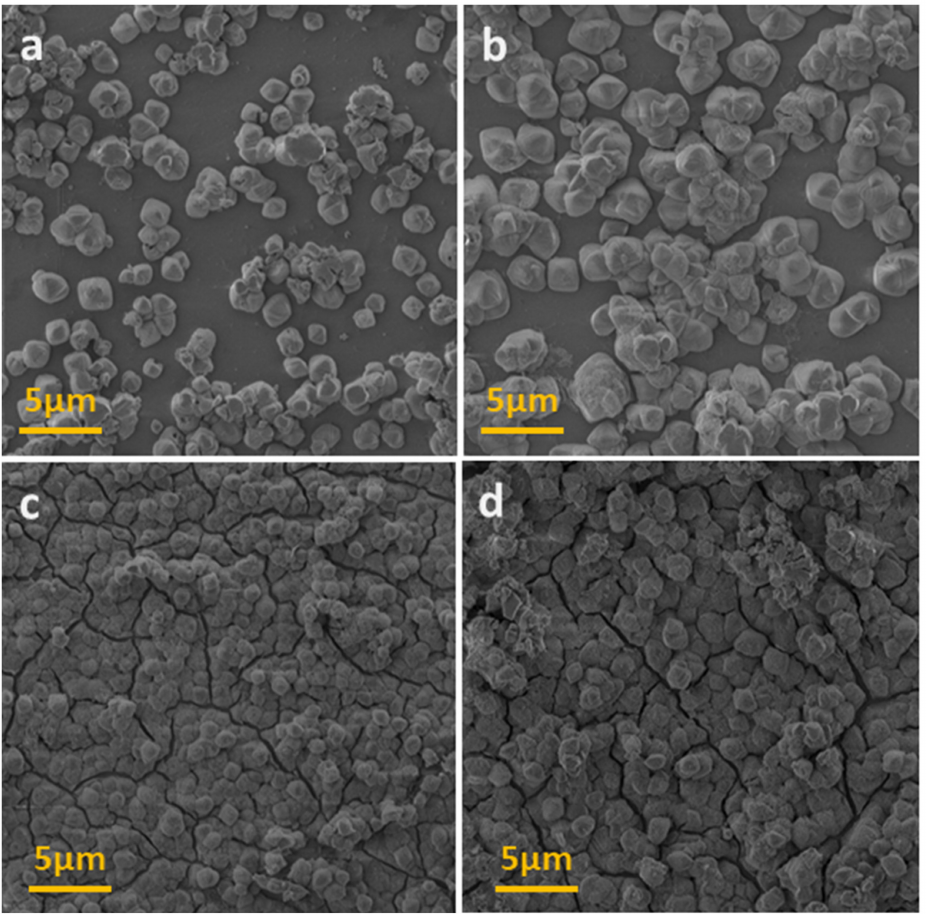
Figure 5. The SEM images of [Fe II (H 2 O) 2 ] 2 [Nb IV (CN) 8 ] · 4H 2 O film obtained after 10 s ( a ); 30 s ( b ); 60 s ( c ); and 180 s ( d ).